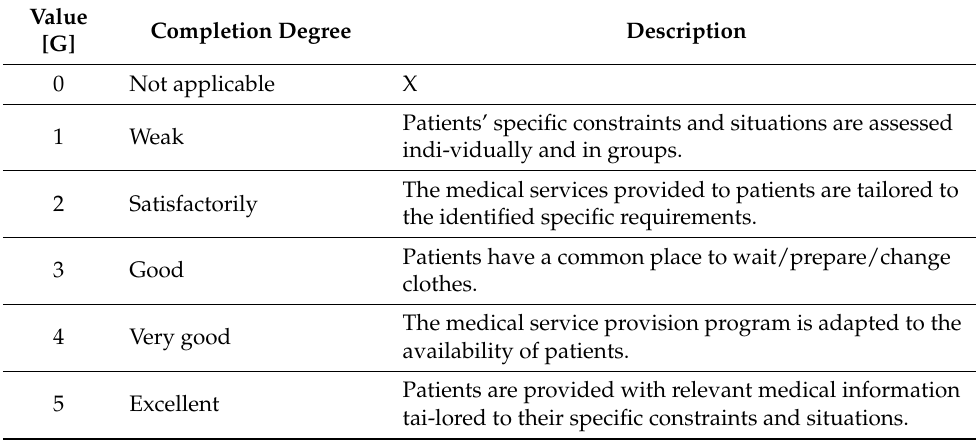
Table 10. Indicator evaluation grid I.A.2—Specific medical approaches.